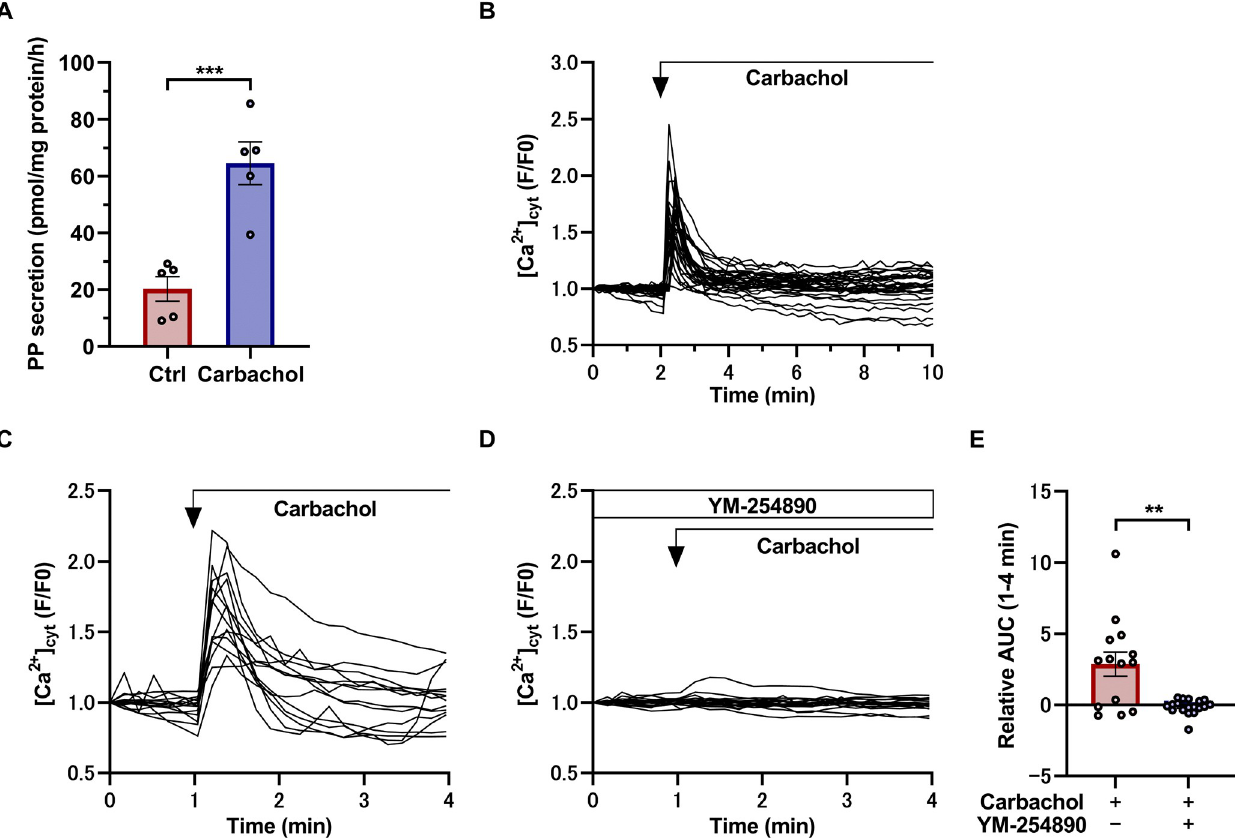
Fig 5. PP secretion stimulated by carbachol. (A) PP secretion from islets of the head region of the pancreas of 10-week-old WT mice, stimulated by 10 μ M carbachol (n = 5 mice) for 1 hour. Values were normalized by the amount of protein from islets in the head region of the pancreas of WT mice. Data are shown as the mean ± SEM, and were analyzed by the two-tailed unpaired t -test. ��� p < 0.001. (B) Representative time course of Ca 2+ responses in Clover + cells (n = 32 cells) from Ppy-Clover-PEST mice (n = 4) stimulated with 10 μ M carbachol. (C, D) Representative time course of Ca 2+ responses in Clover + cells from Ppy-Clover-PEST mice (n = 4) stimulated with 10 μ M carbachol (C, n = 14 cells), or with 10 μ M carbachol and 10 μ M YM-254890 (D, n = 18 cells). (E) Ca 2+ responses to stimulation with 10 μ M carbachol (n = 14 cells), or with 10 μ M carbachol and 10 μ M YM-254890 (n = 18 cells) in Clover + cells from Ppy- Clover-PEST mice. Data are shown as the mean ± SEM, and were analyzed by the unpaired t -test. �� p < 0.01. AUC: Area under the curve.